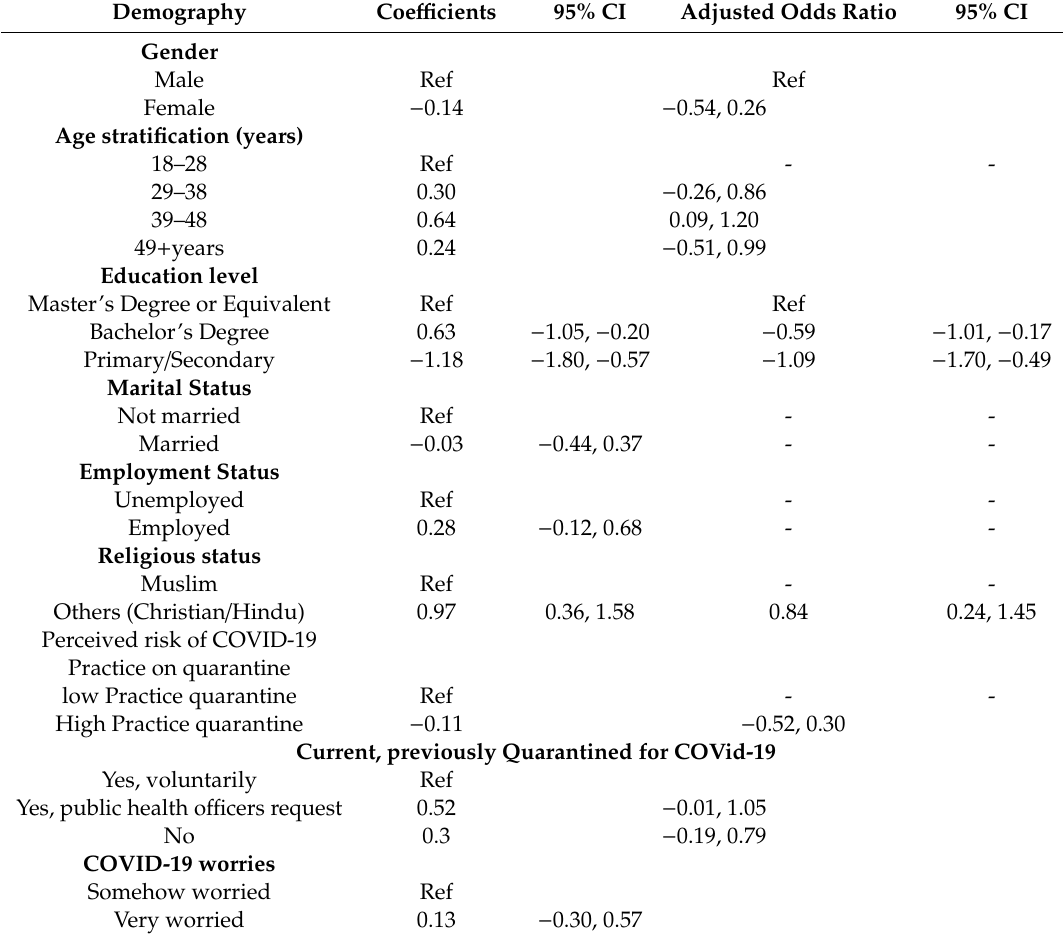
Table A2. Coe ffi cients for factors associated with the knowledge of COVID-19 among the respondents in Bangladesh during the early lockdown period. Confidence intervals CI including zero are not significant .